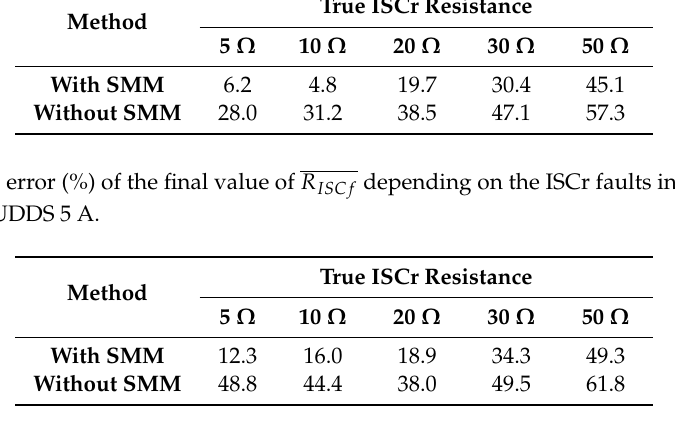
Table 2. Relative error (%) of the final value of R ISCf depending on the ISCr faults in the experiment with cell A and DST 5 A.